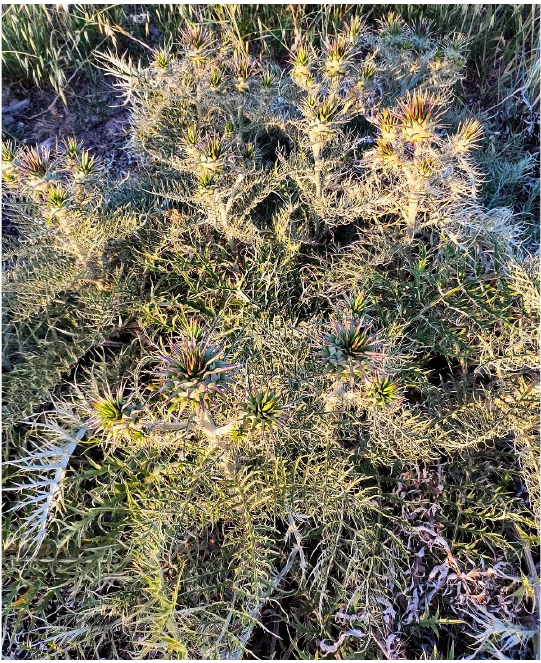
Figure 8. Cynara cardunculus (L.) subsp. sylvestris Lam. (Syracuse, Italy).